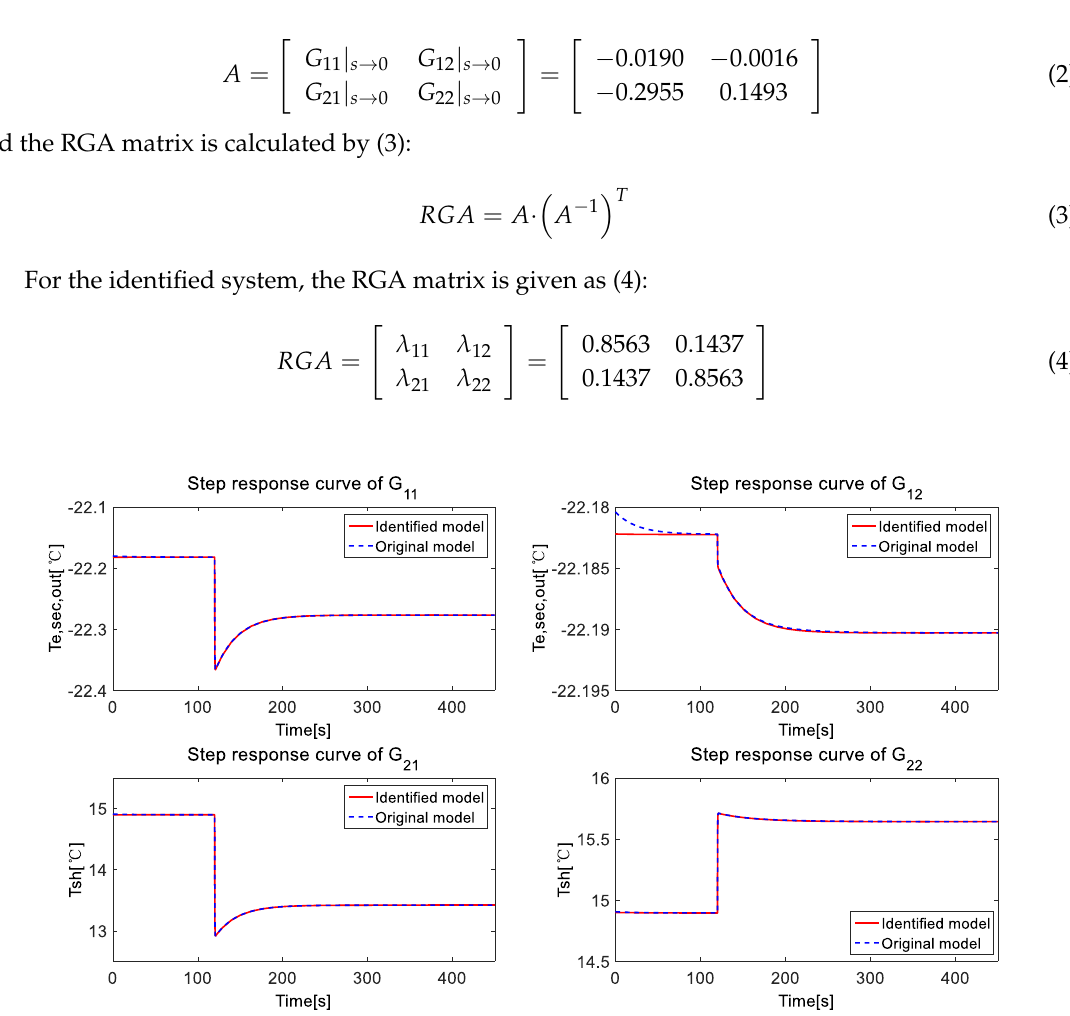
Figure 5. Comparison of the step response curves of the identified model and the original model.